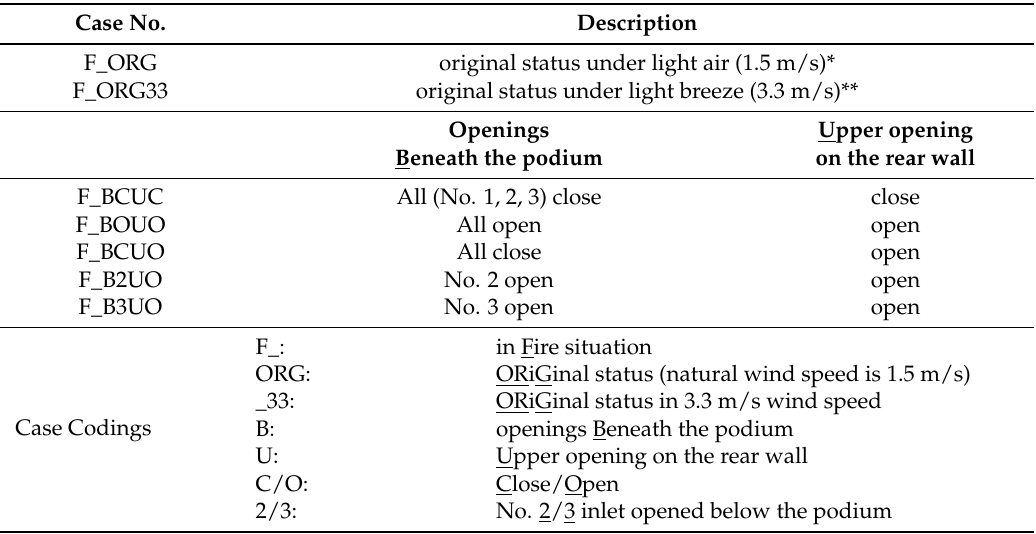
Table 4. The codings of fire